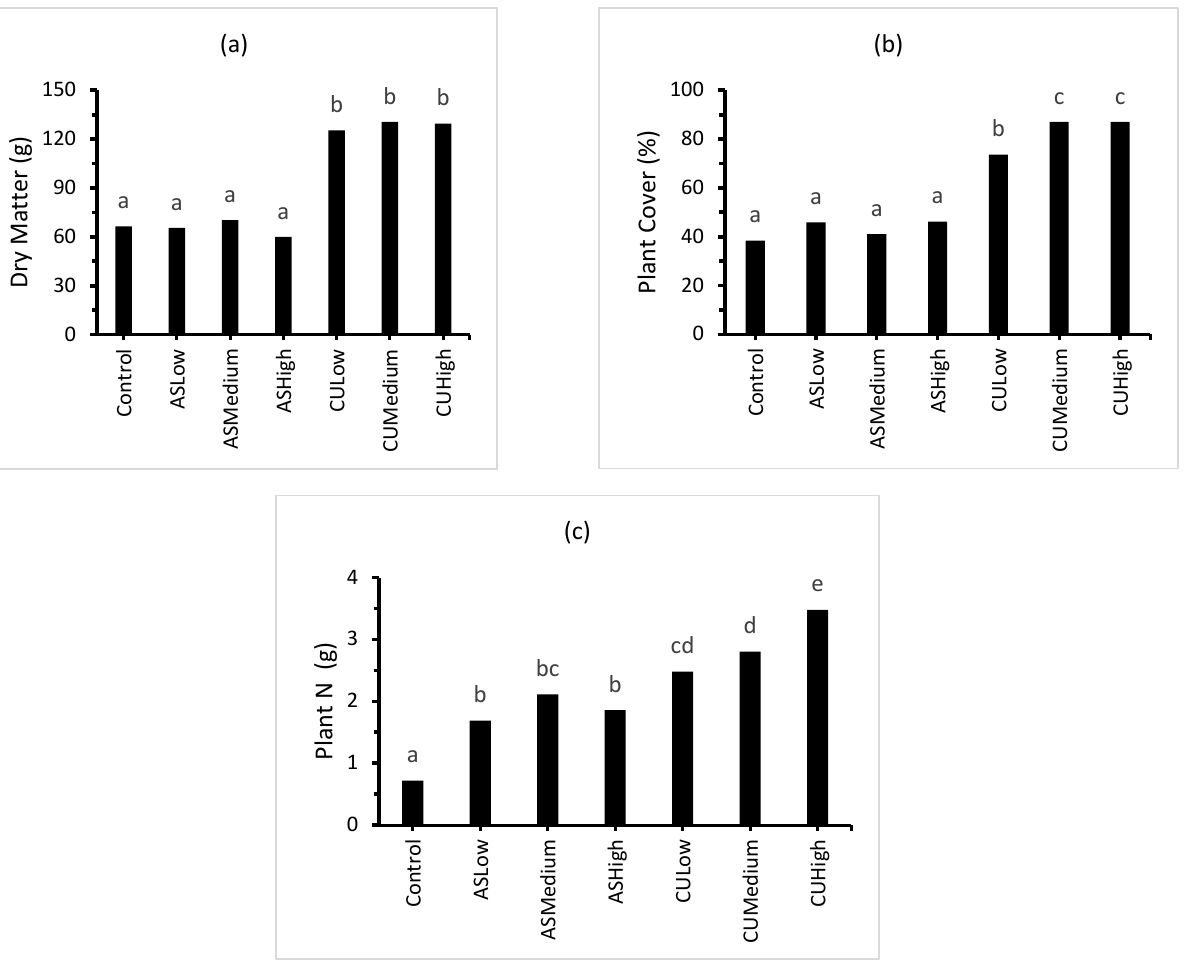
Figure 3. Effect of treatment on: ( a ) percentage plant cover; ( b ) plant biomass; and ( c ) plant total N. Bars represent the mean of three replicates ( n = 3) and bars designated by the same letter are not significantly different at ( p < 0.05).